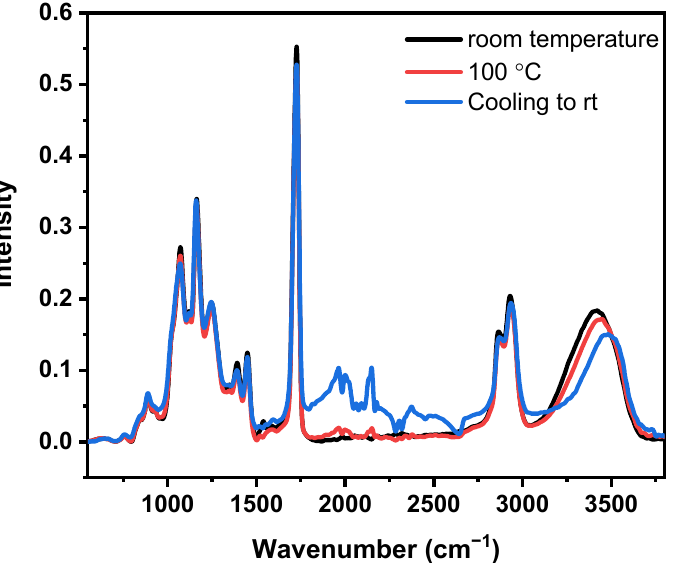
Figure 4. A comparison of the FTIR spectra of Vitrimer 4 at room temperature, 100 °C and cooling to room temperature after 100 °C.